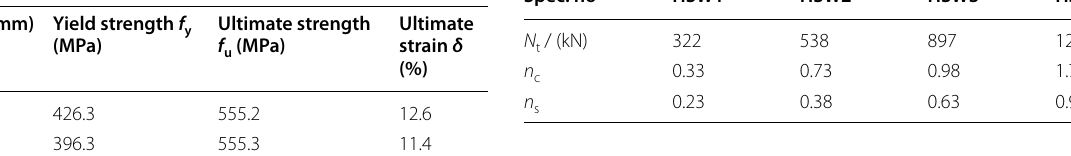
Table 1 Material properties of steel rebar used in experimental specimens.